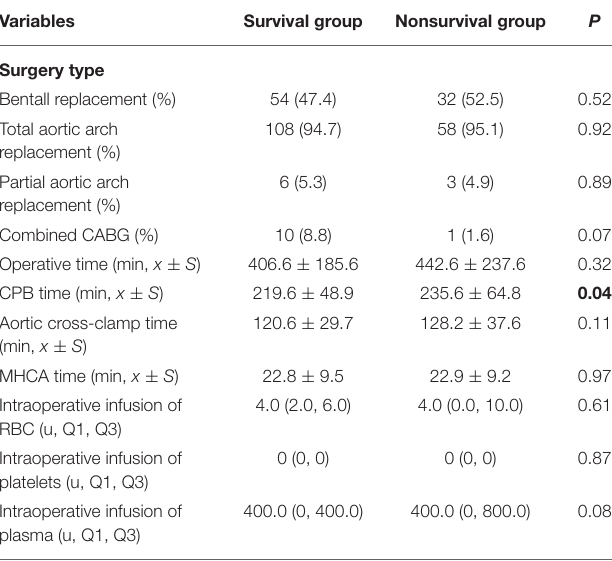
TABLE 2 | Intraoperative variables in the survival and nonsurvival